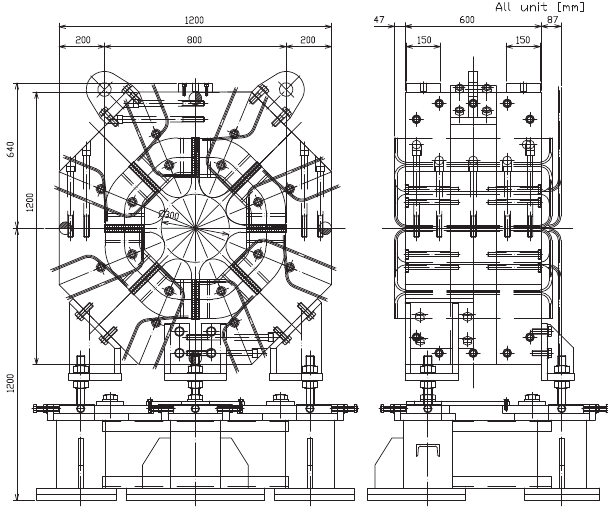
FIG. 12. Comparison of measured and calculated field gradient at octupole magnet for 800 T = m